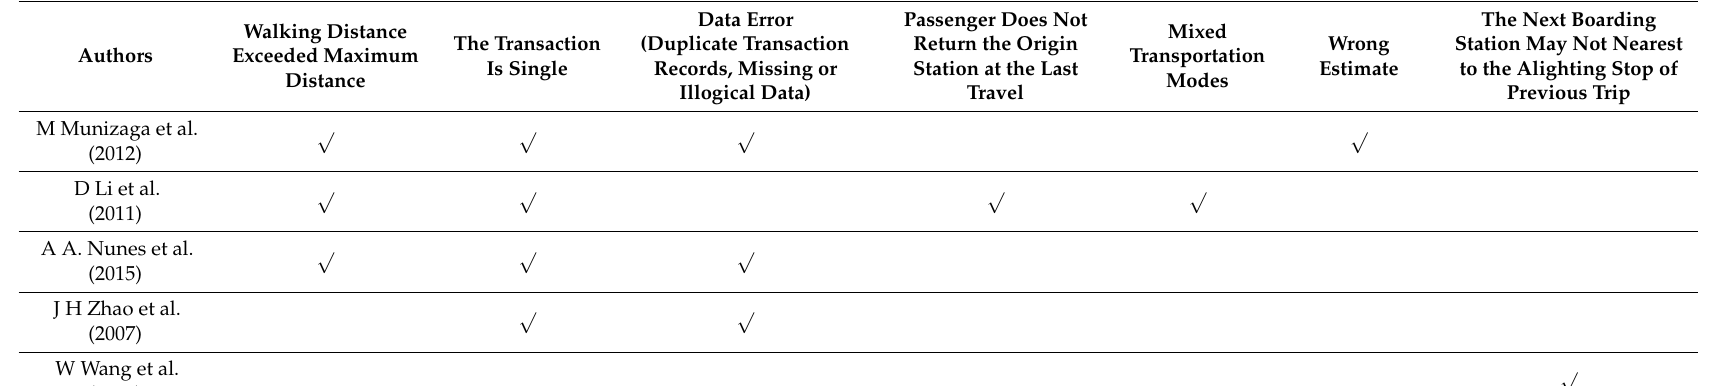
Table 10. Possible problems in existing